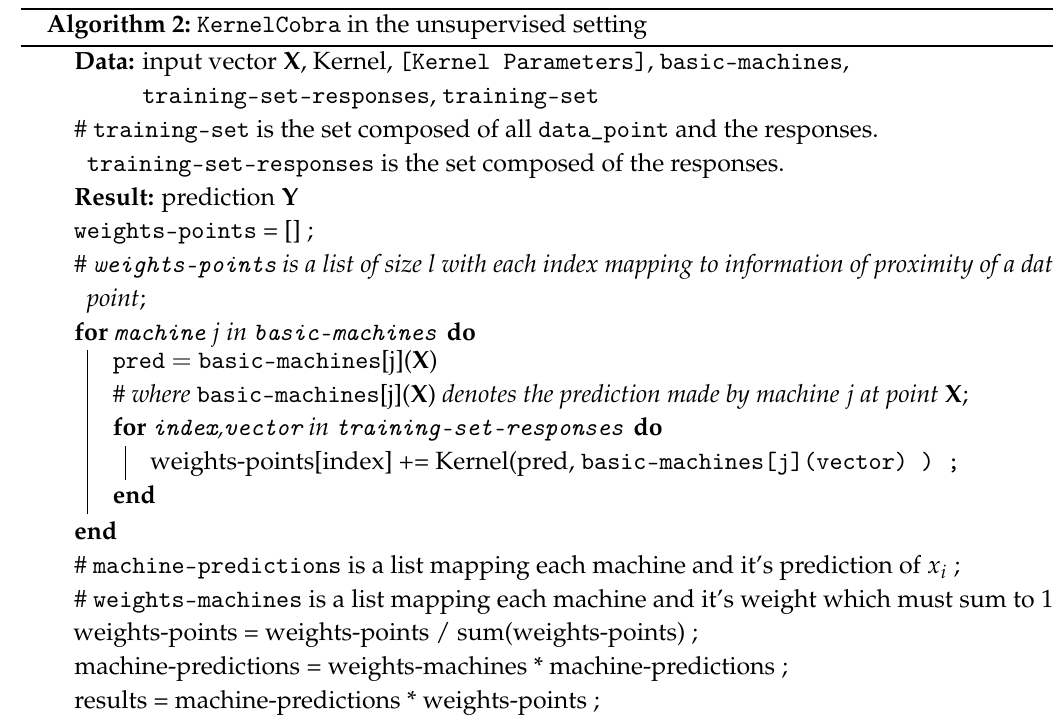
Algorithm 2: KernelCobra in the unsupervised